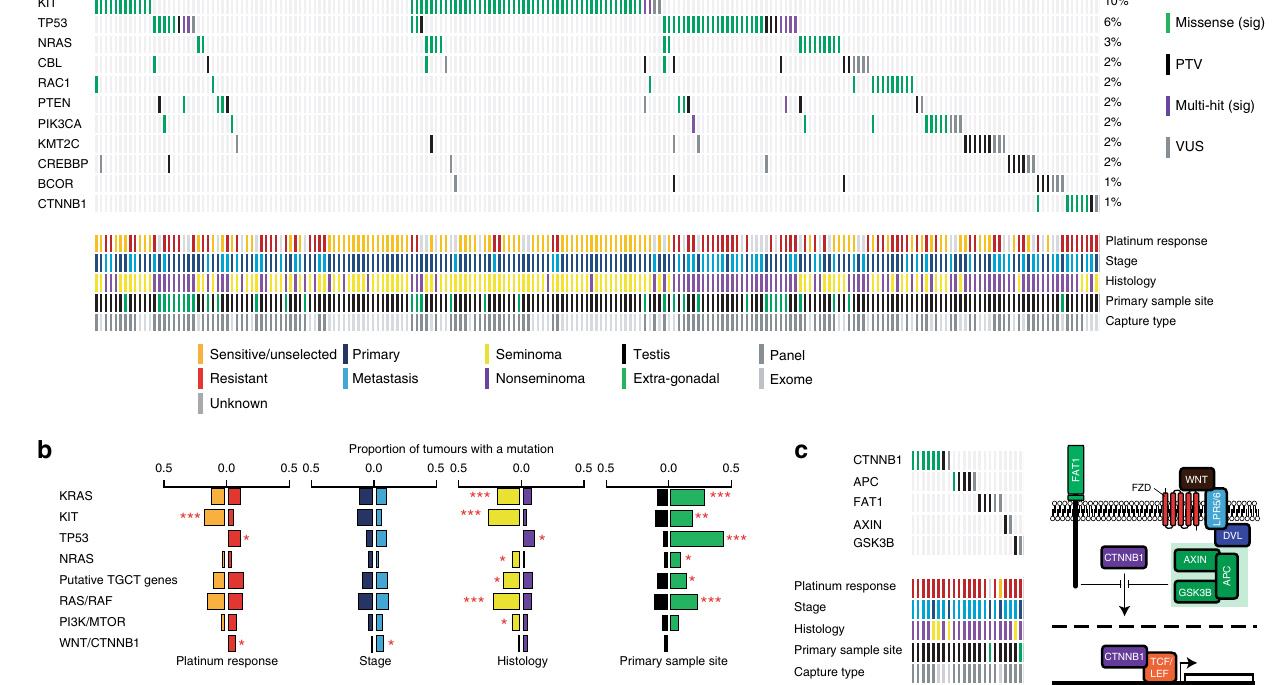
Fig. 3 Mutational landscape of cancer driver genes in TGCT. a Oncoplot showing the cancer driver genes most frequently mutated across 631 index TGCTs from the full sample series (ICR1, ICR2, DFCI, TCGA, MSK and FDM). Only TGCTs carrying a mutation in one of the displayed genes are shown ( n = 207). b Oncogenic mutation frequencies in individual genes/gene sets across index TGCTs with the relevant available data, comparing: platinum- sensitive/unselected ( n = 284, orange) vs. platinum-resistant ( n = 244, red) tumours; primary ( n = 435, dark blue) vs. metastatic ( n = 196, light blue) tumours; seminomas ( n = 204, yellow) vs. nonseminomas ( n = 417, purple); and testicular ( n = 584, black) vs. extragonadal ( n = 47, green) primary sample site. Asterisks denote p values derived from two-sided multivariable logistic regression, adjusting for platinum response, histology, stage, capture type, sample material and primary sample site.* p < 0.05, ** p < 0.01, *** p < 0.001. Exact p values are provided in Supplementary Table 4. Putative TGCT genes: CBL , RAC1 , PIK3CA , KMT2C , CREBBP , BCOR and CTNNB1 . c WNT/CTNNB1 pathway alterations are overrepresented in platinum-resistant metastatic TGCTs ( n = 22) with the majority consistent with pathway activation. Pathway components that negatively regulate CTNNB1 are shown in green.